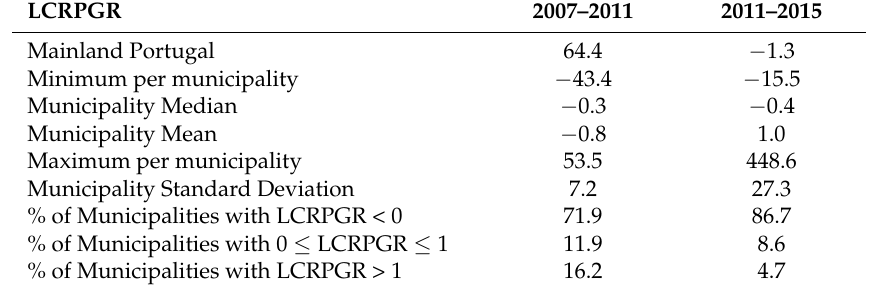
Table 4. Characterisation of the LCRPGR estimates produced by COS for the periods 2007–2011 and 2011–2015.